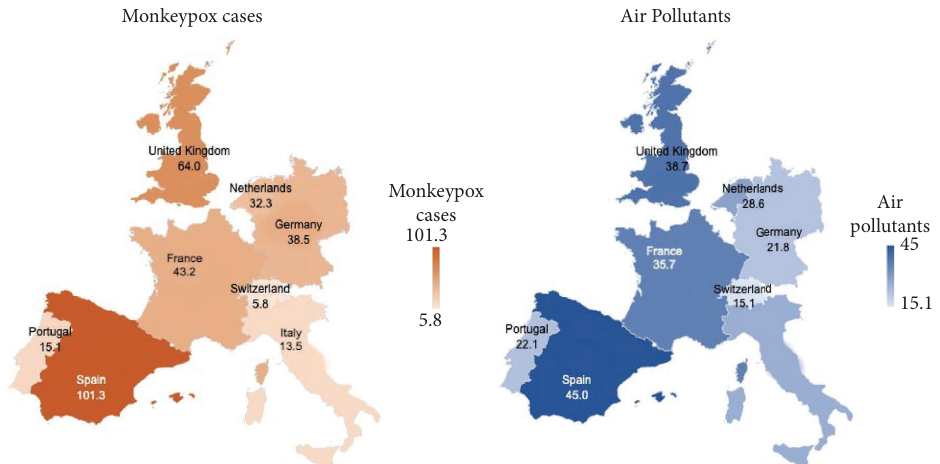
Figure 1: Mean levels of environmental pollutants PM2.5, PM10, NO Table 1: Te mean levels for air pollutants PM2.5, PM10, NO Countries Spain